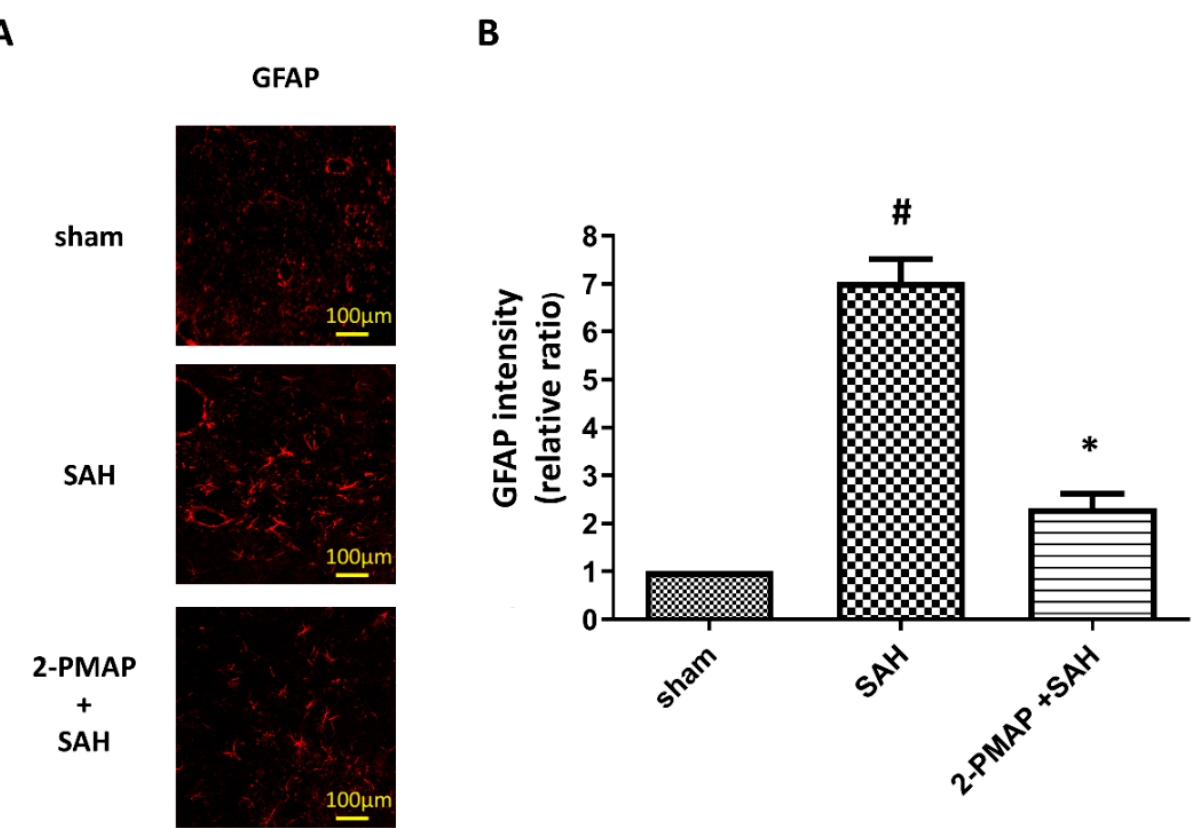
Figure 6. 2-PMAP decreased astrocyte activation in SAH rats. Slices of brain tissues were prepared in rats treated with the administration of 2-PMAP, or not, 48 h after the SAH. Immunofluorescence staining showing reactive astrogliosis in brain tissues after SAH. ( A ) Representative images of reactive astrogliosis in the brain tissues. Scale bars: 100 µ m. ( B ) Relative fluorescence intensity of GFAP. Data are shown as mean + SD ( n = 6 for each group); *, p < 0.05, significantly different from the SAH group. #, p < 0.05, significantly different from the sham group.